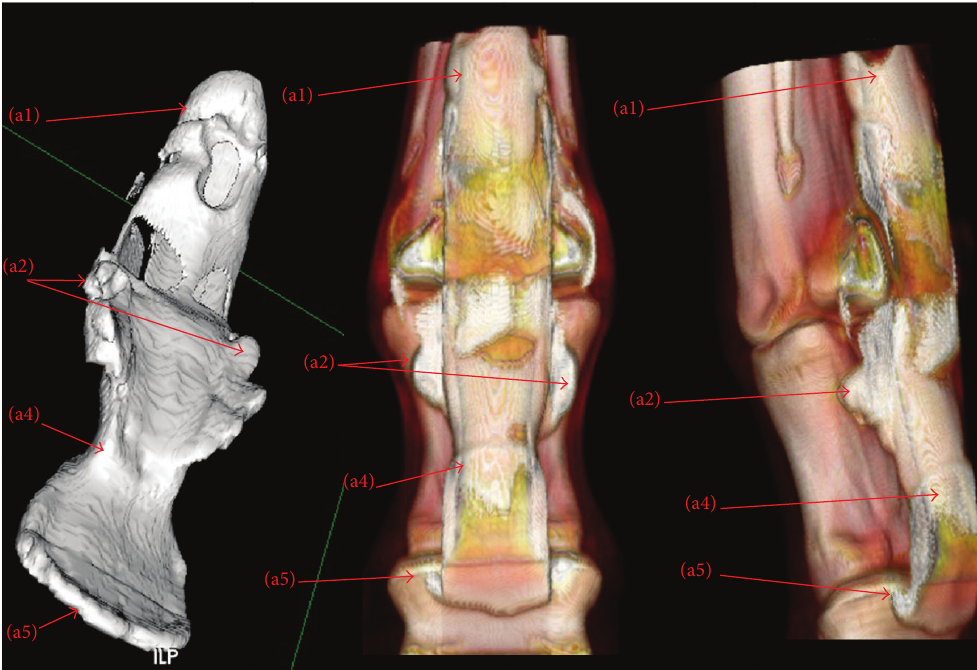
Figure 4: 3D reconstruction. (1) Surface rendering; (2) volume rendering. (a1) Dorsal proximal recess, (a2) palmar proximal recess, (a3) collateral recess, (a4) palmar distal recess, and (a5) dorsal distal